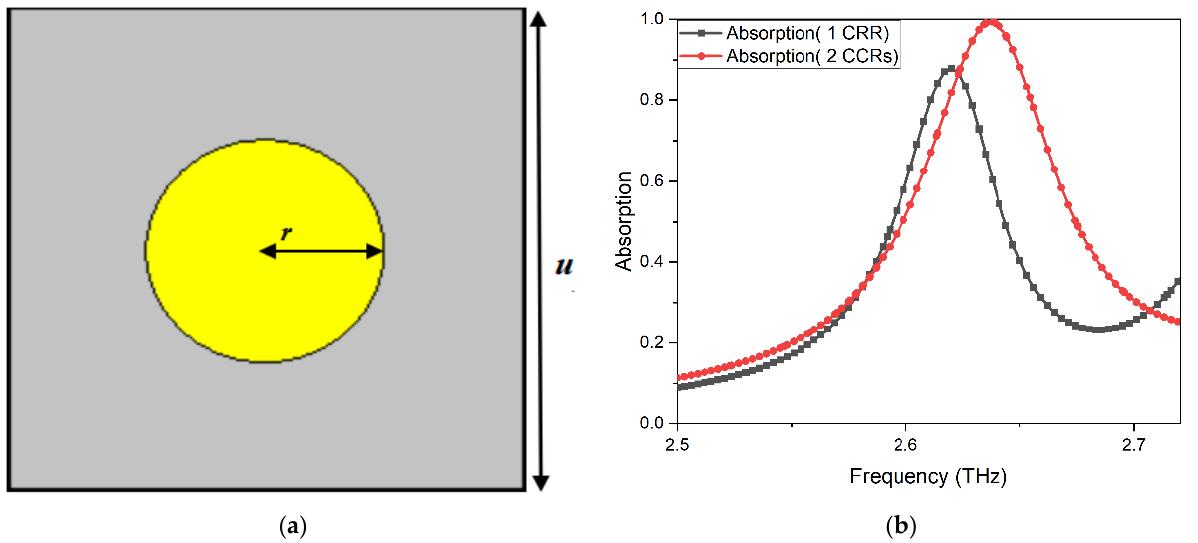
Figure 3. ( a ) Proposed absorber with single CRR; ( b ) comparison of the absorption spectrum for design with single and double CRRs.